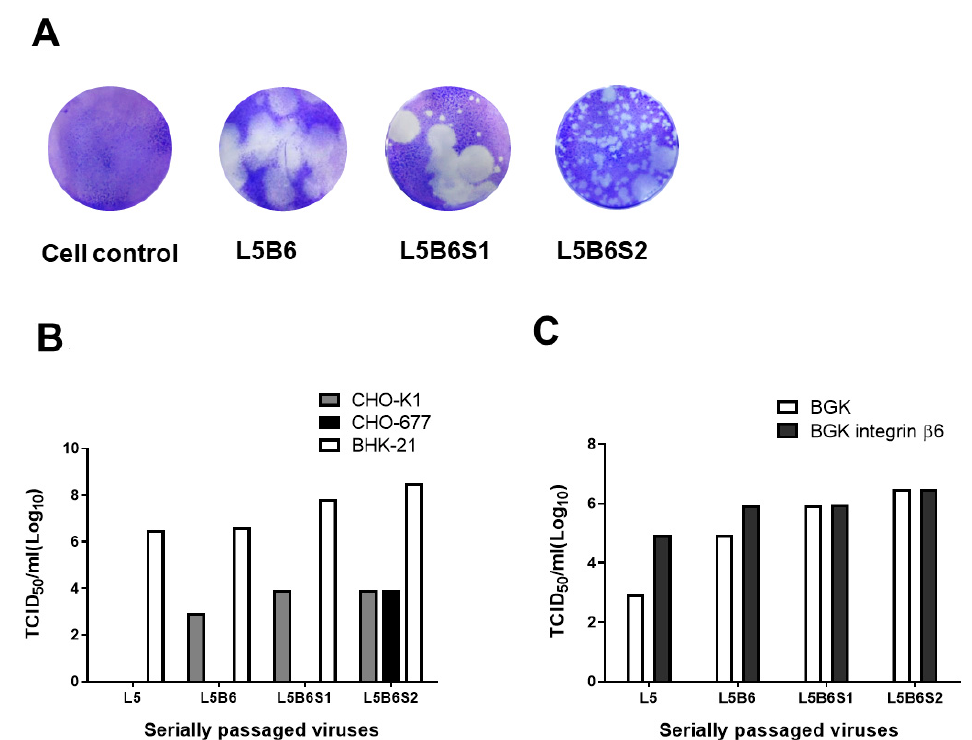
Figure 1. The change in receptor usage of the O/SKR/Andong/2010 virus following serial passaging. The O/SKR/Andong/2010 virus used in this study was serially passaged five times in porcine kidney (LFBK) cells (L5); five times in LFBK cells and six times in adherent baby hamster kidney (BHK)-21 cells (L5B6); five times in LFBK cells, six times in adherent BHK-21 cells and once in suspension BHK-21 cells (L5B6S1); or five times in LFBK cells, six times in adherent BHK-21 cells and two times in suspension BHK-21 cells (L5B6S2). The plaque phenotypes were compared using plaque forming assay ( A ). Virus titrations were performed in Chinese hamster ovary (CHO)-K1, CHO-677 and adherent BHK-21 cells to test the viral usage of the heparan sulfate (HS) receptor ( B ) and were performed in black goat kidney (BGK) and BGK-integrin- β 6 cells to test the dependency of the integrin receptor ( C ).